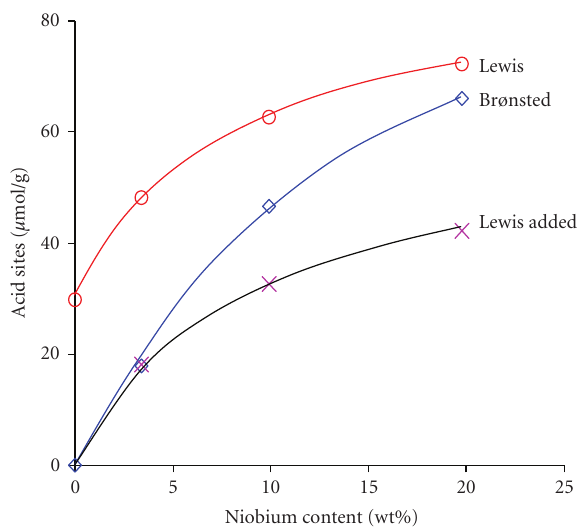
Figure 8: Correlation between the niobium content and the amount of acid sites of the